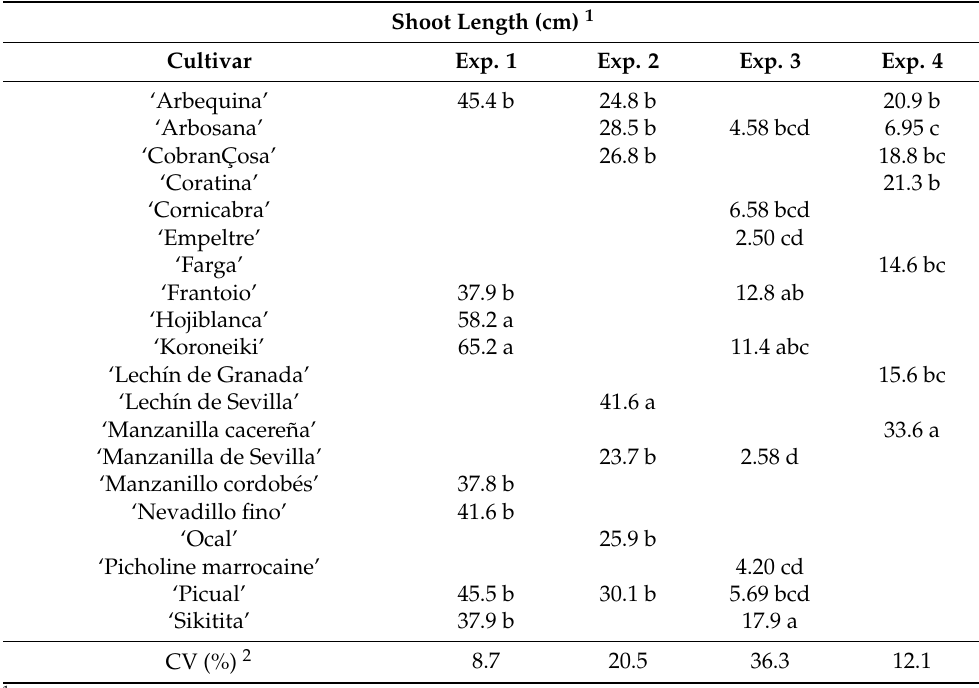
Table 1. Vegetative growth of 20 olive cultivars at the end of the experiments in response to 100 ppm N application.